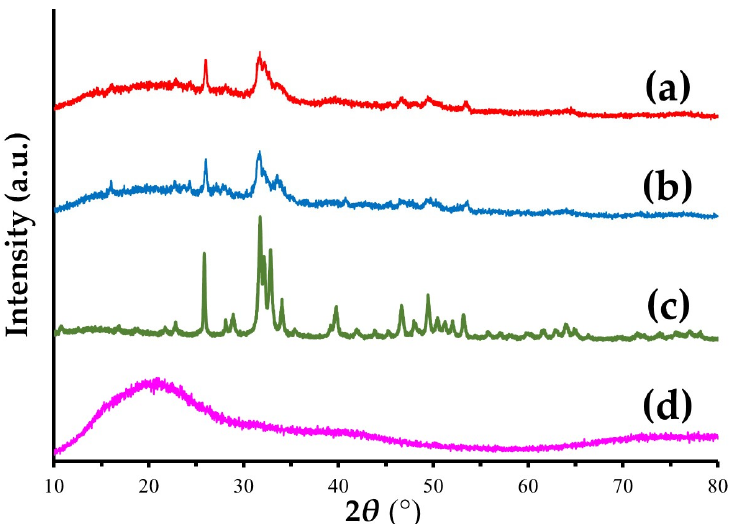
Figure 5. XRD patterns of ( a , b ) two Col/Hap composites (AI 20 min 5Cy Col/Hap and AI 60 min 5Cy Col/Hap), ( c ) Hap standard, and ( d ) Col control.